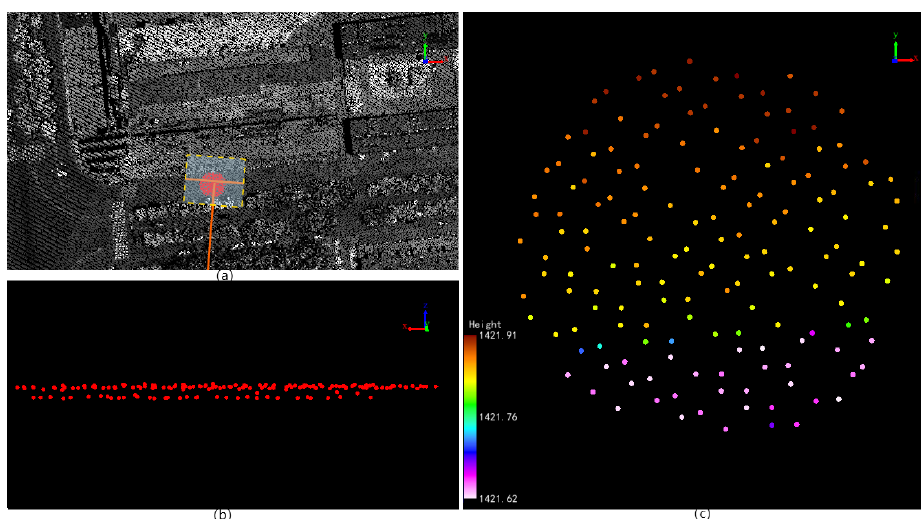
Figure 2. ( a ) One selected flat area; ( b ) Profile of flat area; ( c ) Top view of the selected flat area. The road in the study area is considered to be a flat area, but we can still see a maximum height difference of sub-meter levels among the selected road points.